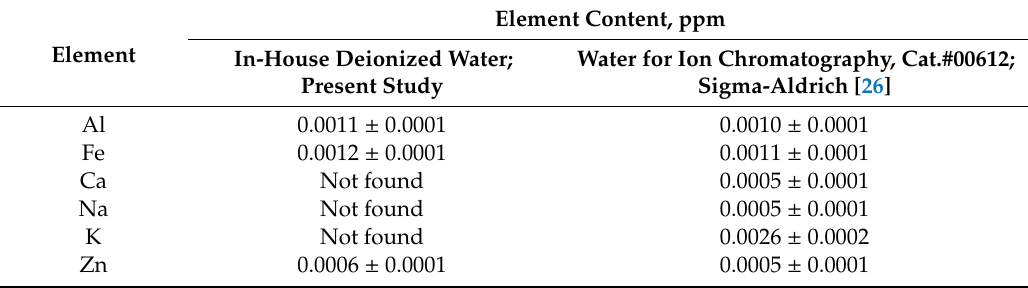
Table 2. In-house deionized water characterization by